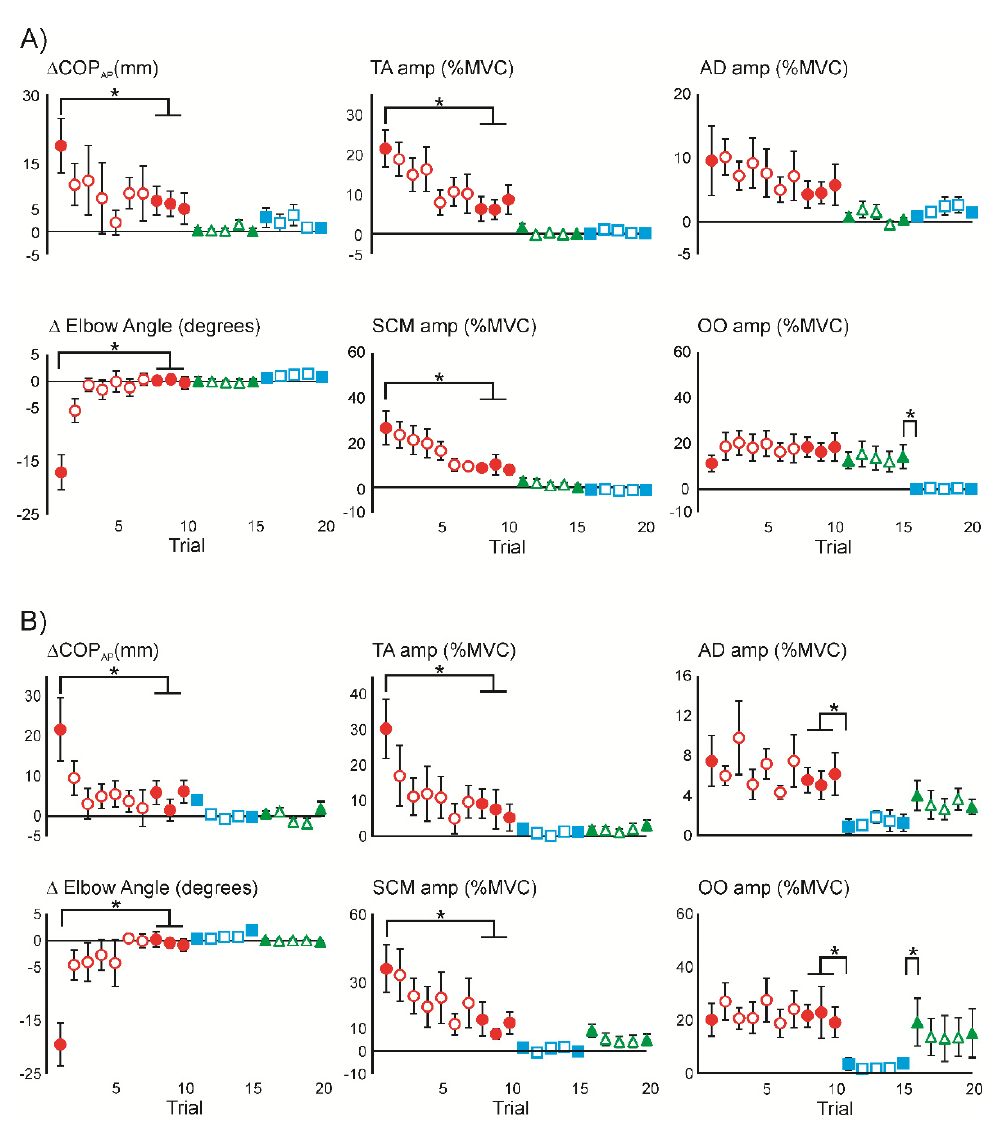
Figure 5. Trial-by-trial mean (SE) mechanical and muscle response amplitudes for participants who habituated to the COMBINED stimuli initially. ( A ) Participants subsequently received the STARTLE stimuli, followed by the DISPLACEMENT. ( B ) Participants subsequently received the DISPLACEMENT, followed by the STARTLE. Asterisks indicate di ff erences identified by Tukey’s HSD comparisons ( p < 0.05). Blue squares, DISPLACEMENT; Red circles, COMBINED; Green triangles, STARTLE. Closed symbols indicate data points used in the statistical analysis. TA, tibialis anterior; AD, anterior deltoid; SCM, sternocleidomastoid; OO, orbicularis oculi; COP AP , center of pressure anterior–posterior; MVC, maximum voluntary